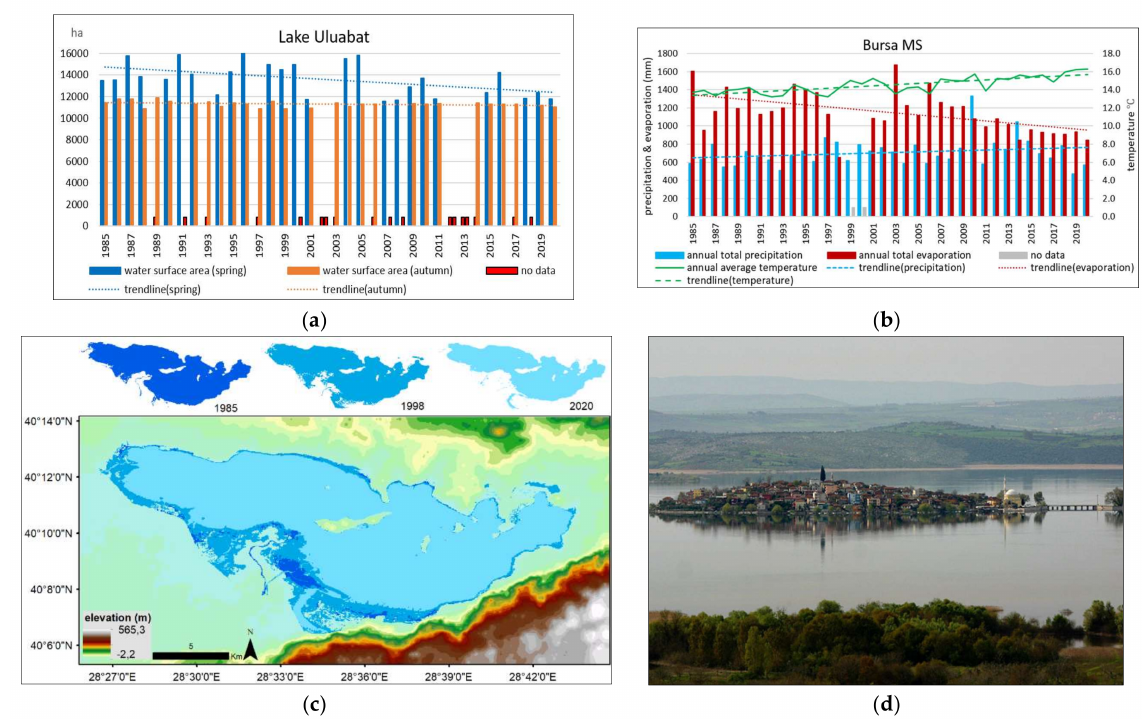
Figure 11. Lake Uluabat: ( a ) 1985–2020 annual (spring and autumn) surface water areas; ( b ) representative meteorological station data (precipitation, evaporation, and temperature); ( c ) water surface area changes (NDWI); ( d ) view of the site [90].